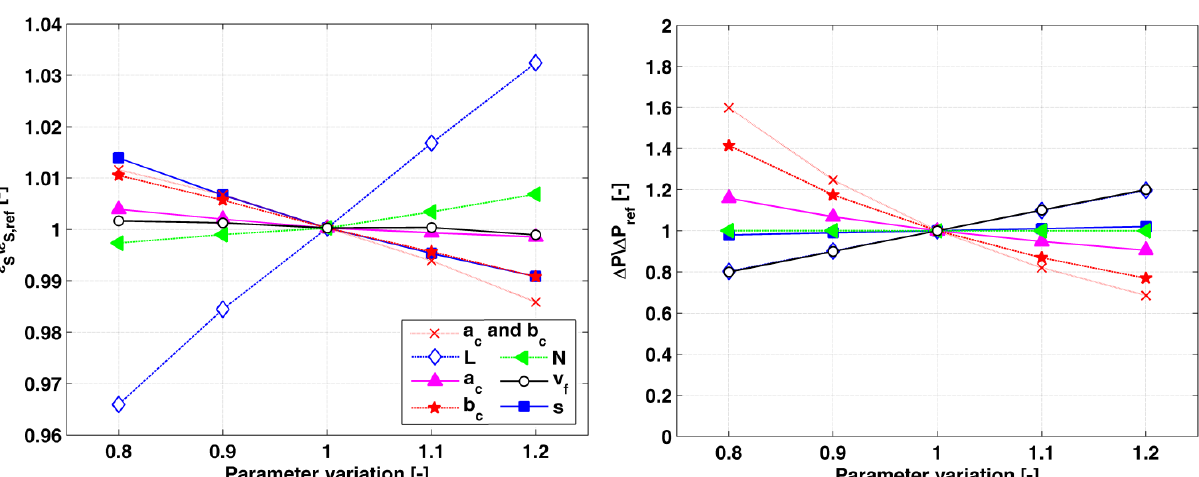
Figure 6. Parametric analysis of sensible effectiveness and pressure drop. (Reference conditions: a c = 2 mm, b c = 2 mm, s = 0.06 mm, L = 0.2 m, v f = 1.5 m·s −1 , N = 10 rev·min −1 T su,in = 10 °C, T ex,in = 30 °C, X su,in = 3.7 g·kg −1 , X ex,in = 7.7 g·kg −1 , φ su,in = 50% and φ ex,in = 30%).